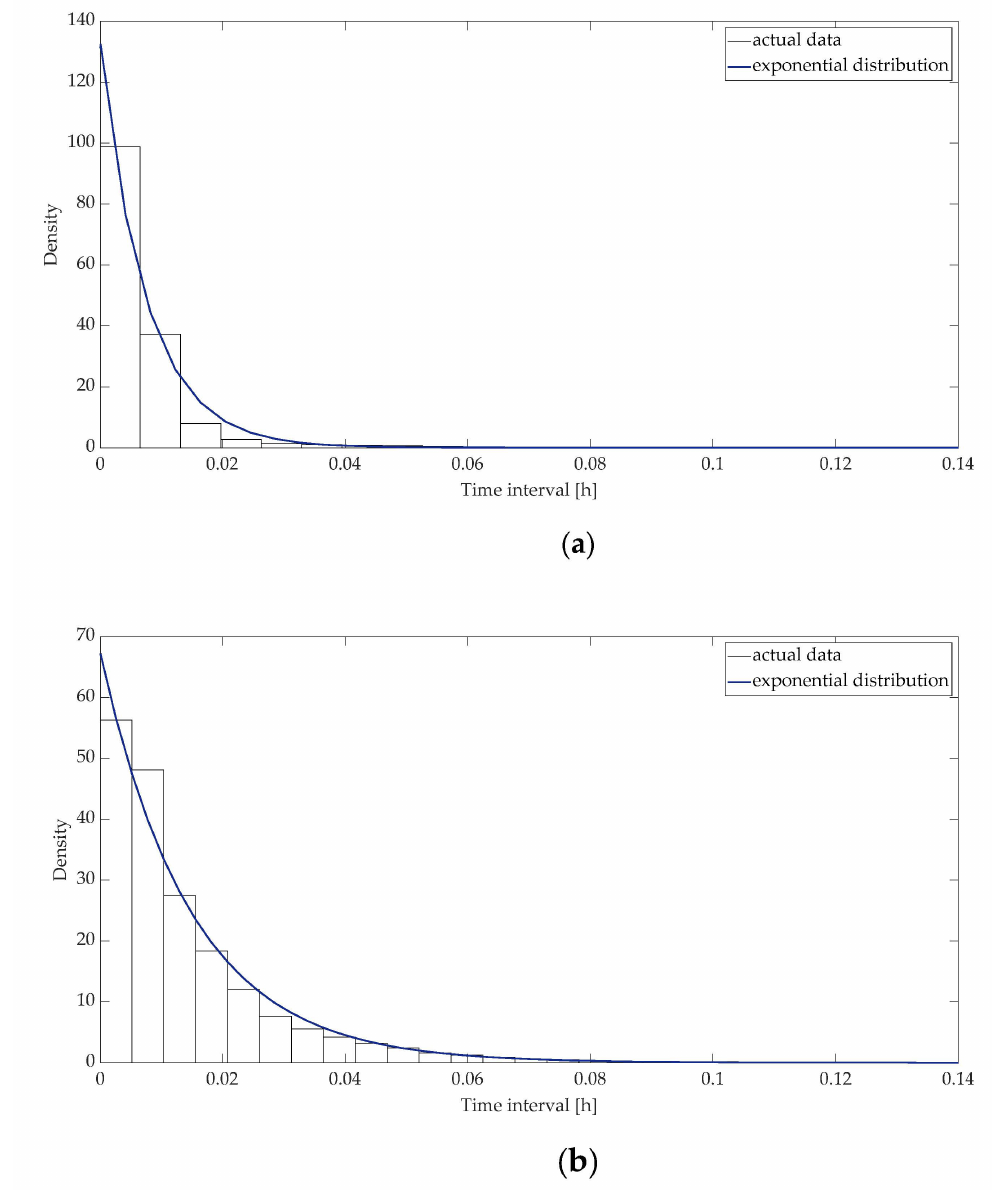
Figure 17. Approximation of the time occurrence of regulation power to an exponential pdf in Case 2 ( a ) and Case 3 ( b